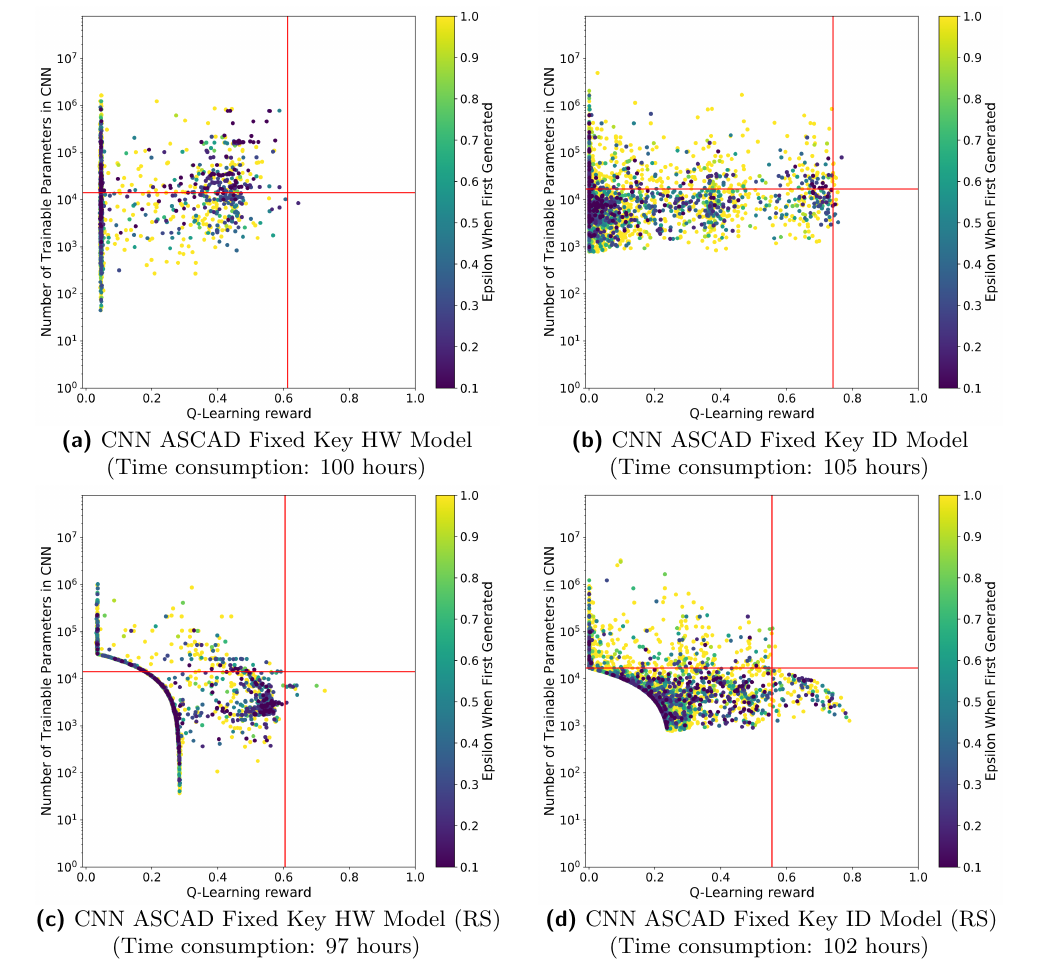
Figure 4: An overview of the number of trainable parameters, reward, the total search time, and the ε a neural network was first generated for the ASCAD with fixed key dataset experiments. The red lines indicate the amount of trainable parameters and the Q-Learning Reward of the state-of-the-art CNNs from Zaid et al.